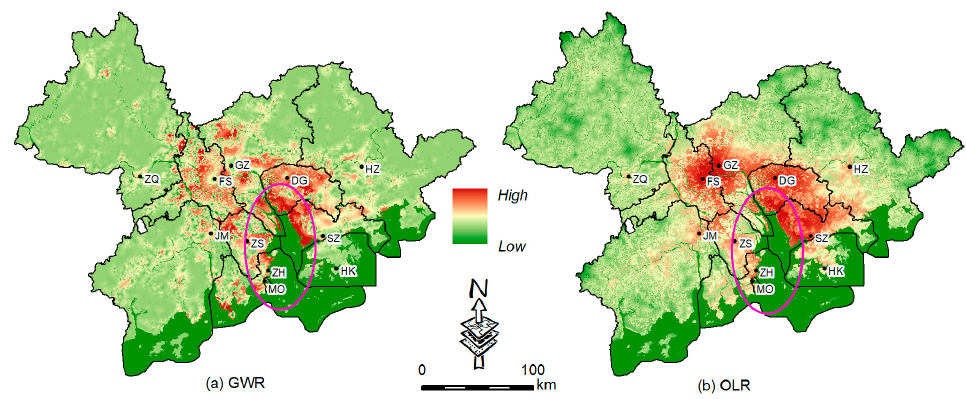
Figure 6. Urban growth probability in China’s GBA, estimated with ( a ) GWR and ( b ) OLR.